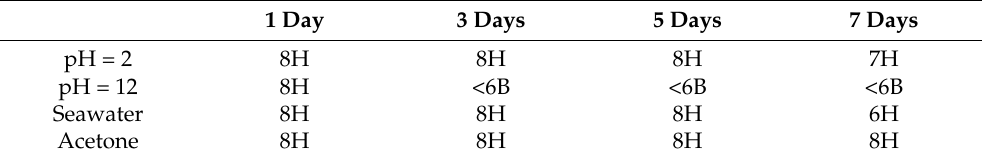
Figure 7. Contact angle of a water droplet on the surface of ( a ) DETA-OSER, before being soaked in HMDS. ( b ) DETA-OSER, after being soaked in HMDS. ( c ) MXDA-OSER, before being soaked in HMDS. ( d ) MXDA-OSER, after being soaked in HMDS. Table 3. The pencil hardness grade of DETA-OSER being soaked in different solutions.